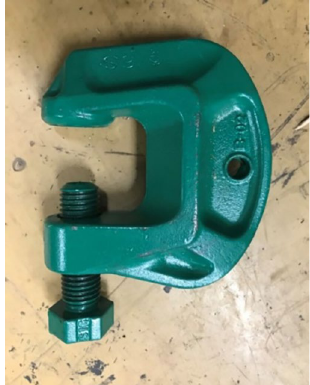
Figure 3. Vise used to seismic retrofit of steel